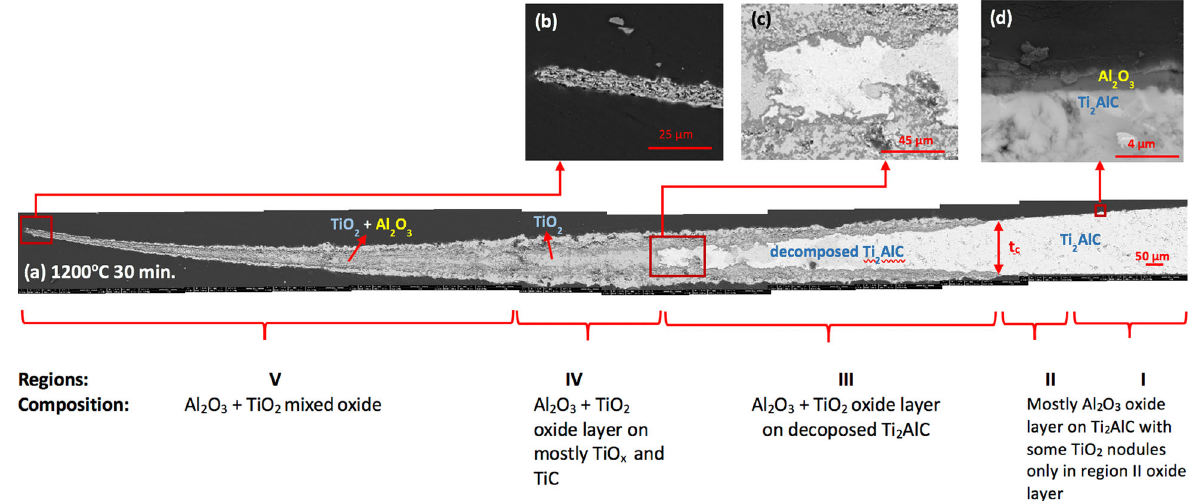
Fig. 7 Breakaway oxidation behavior of Ti 2 AlC. ( a ) Backscattered Electron SEM images of selected wedge-shaped Ti 2 AlC oxidized at 1200 °C for 30 min. Insert b, c, and d shows magni fi ed tip, middle and end, respectively, of the wedge-shaped sample oxidized at 1200 °C for 30 min.